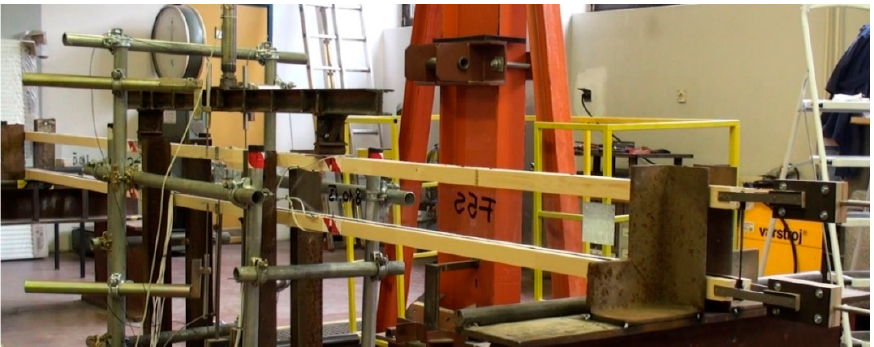
Figure 17. Positioning the specimen between the steel profiles and attaching the weight yoke.